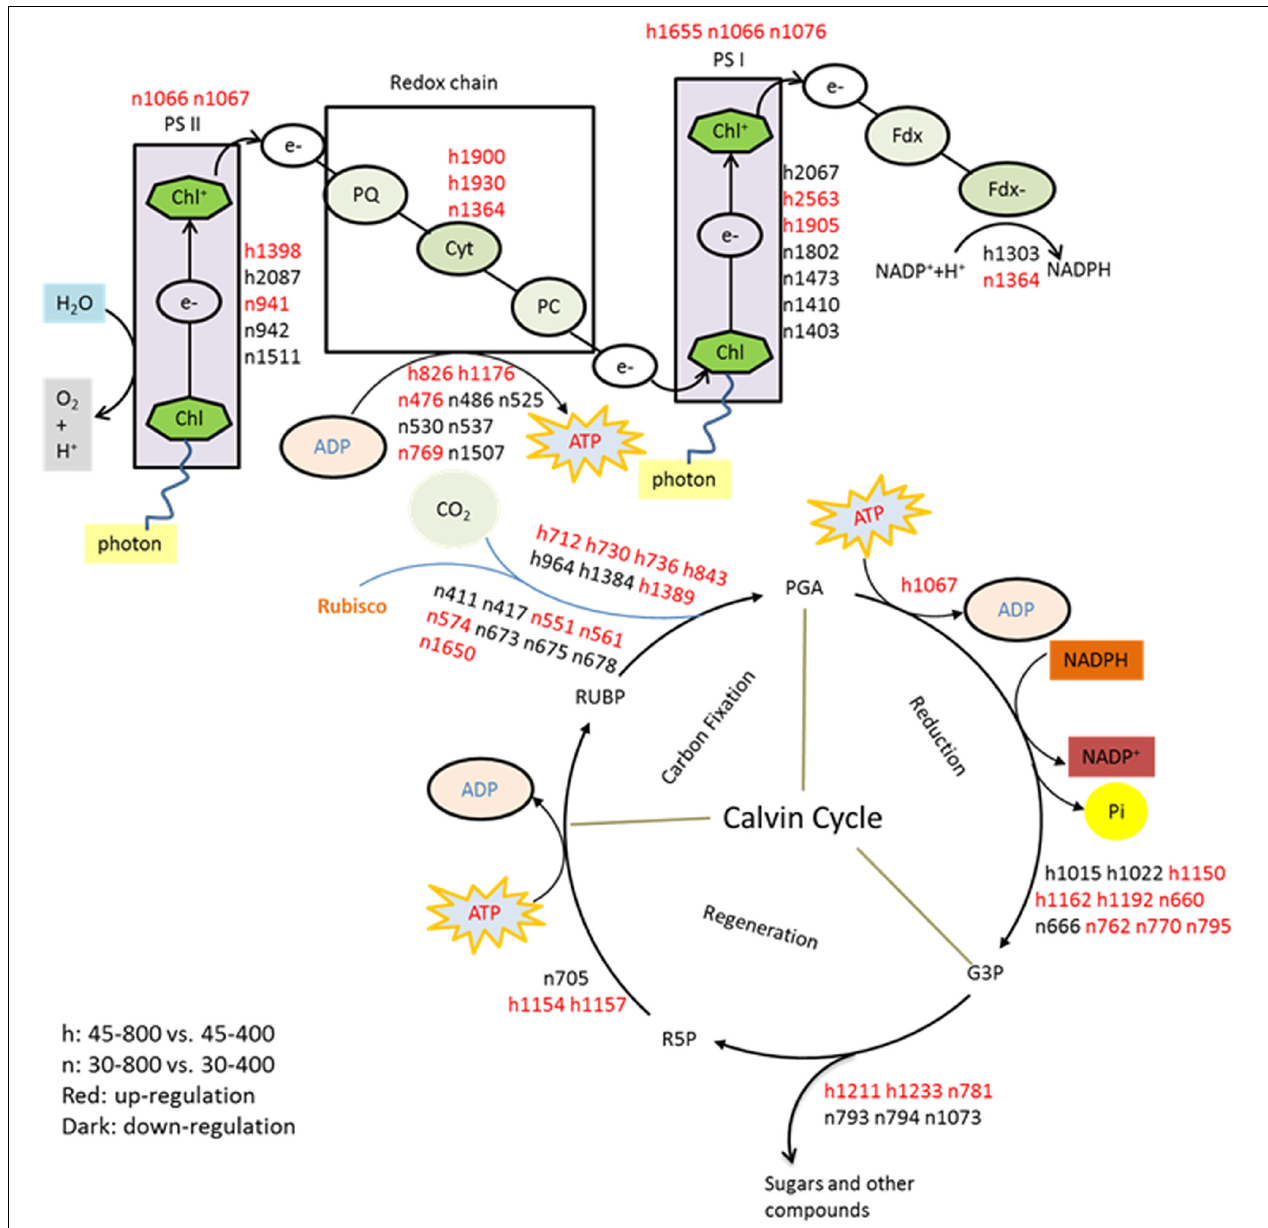
FIGURE 16 | The metabolic pathways associated with differentially expressed proteins. The treatments symbols are 30 and 45 for normal temperature control and heat stress and 400 and 800 for ambient CO 2 and elevated CO 2 concentrations, respectively. Labels with ‘n’ or ‘h’ were same as Table 2 . RuBP, Ribulose 1, 5-bisphosphate; R5P, Ribulose 5-phosphate; Rubisco, Ribulose 1, 5-bisphosphate carboxylase/oxygenase; PGA, 3-phosphoglyceric acid; G3P, Glyceraldehyde 3-phosphate; PC, Plastocyanin; PQ, Plastoquinone; Fd, Ferredoxin; Cyt, Cytochrome